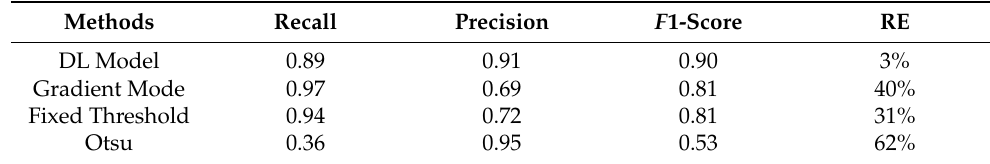
Table 1. Accuracy evaluation indexes of different methods.